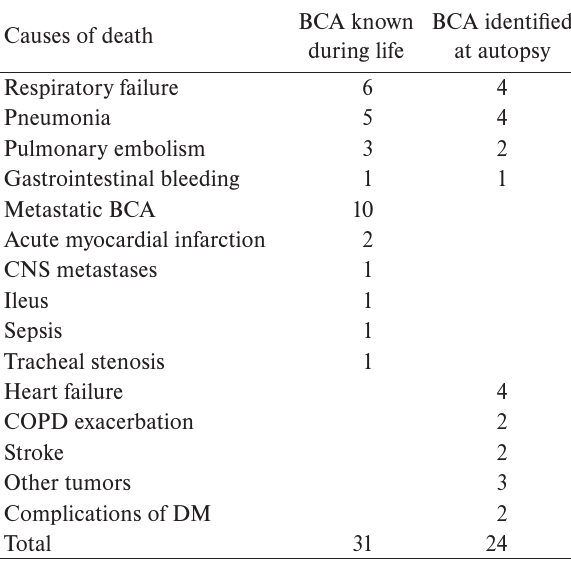
Table 2. Causes of death in patients with lung cancer. Causes of death